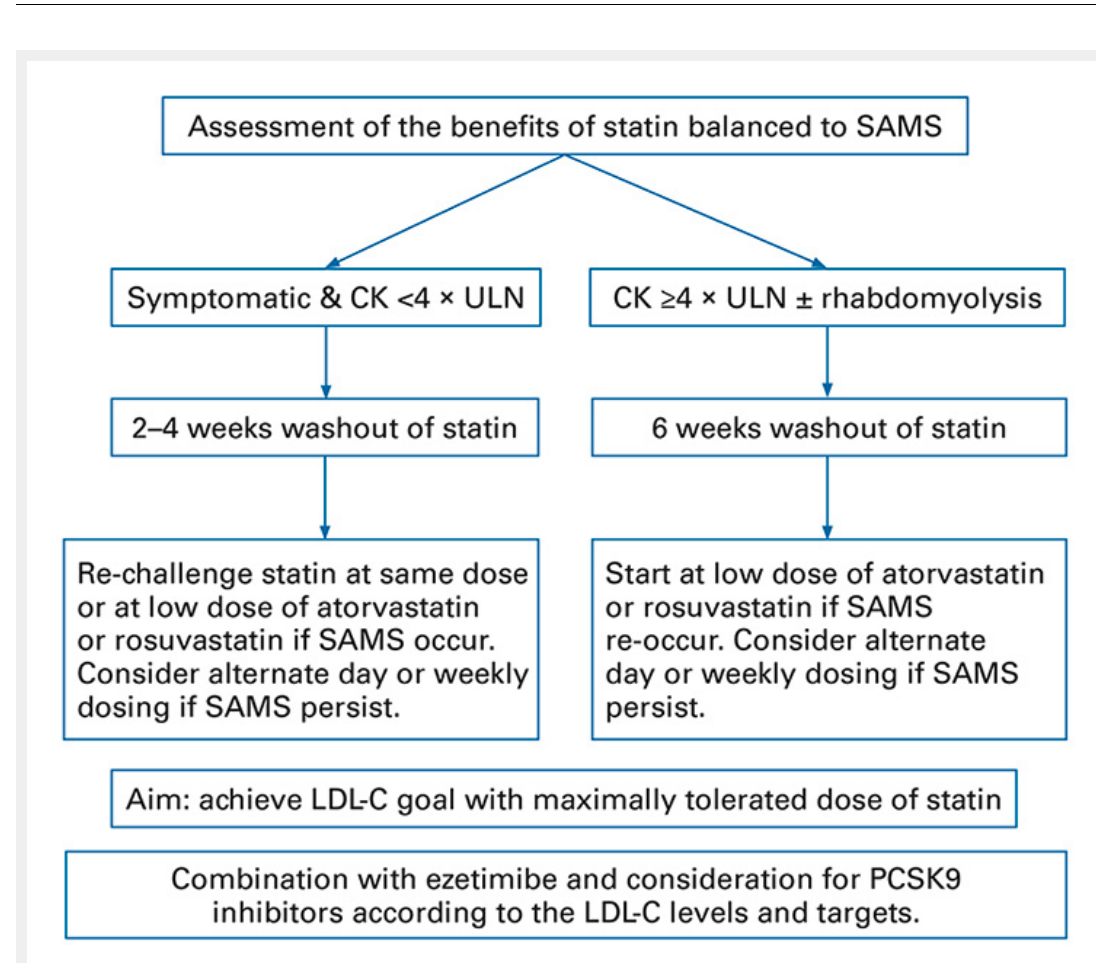
Figure 1 Clinical management of statin-associated muscle symptoms based on the EAS/ESC consensus panel guidelines. CK = creatinine kinase; EAS = European Atherosclerosis Society; ESC = European Society of Cardiology; LDL-C = low-density lipoprotein cholesterol; PCSK9 = proprotein convertase subtilisin kexin 9; SAMS = statin-associated muscle symptoms; ULN = upper limit of normal. Algorithm based on the EAS/ESC consensus document